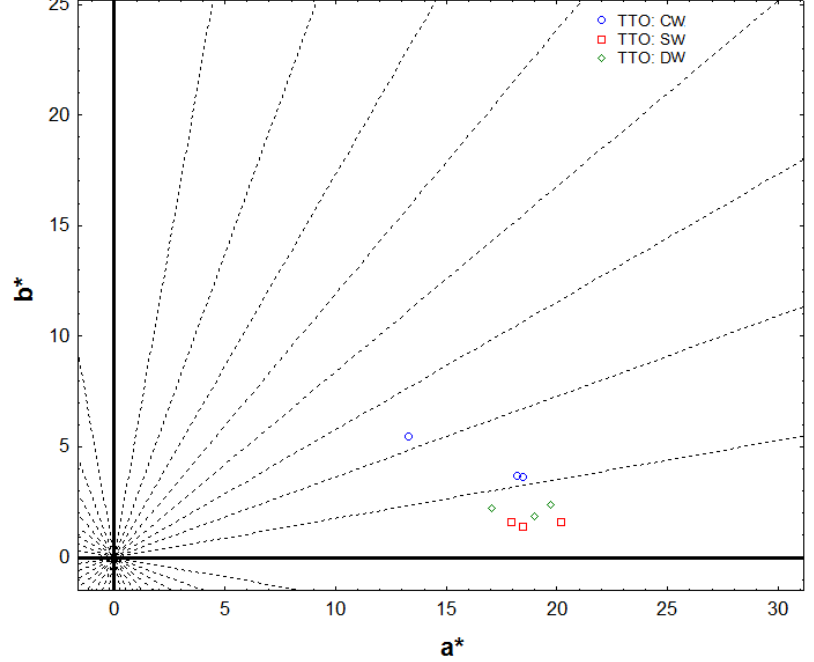
Figure 1. Location of wines at the end of the stabilization phase (120 days) on the CIELAB (a *b *)- diagram.